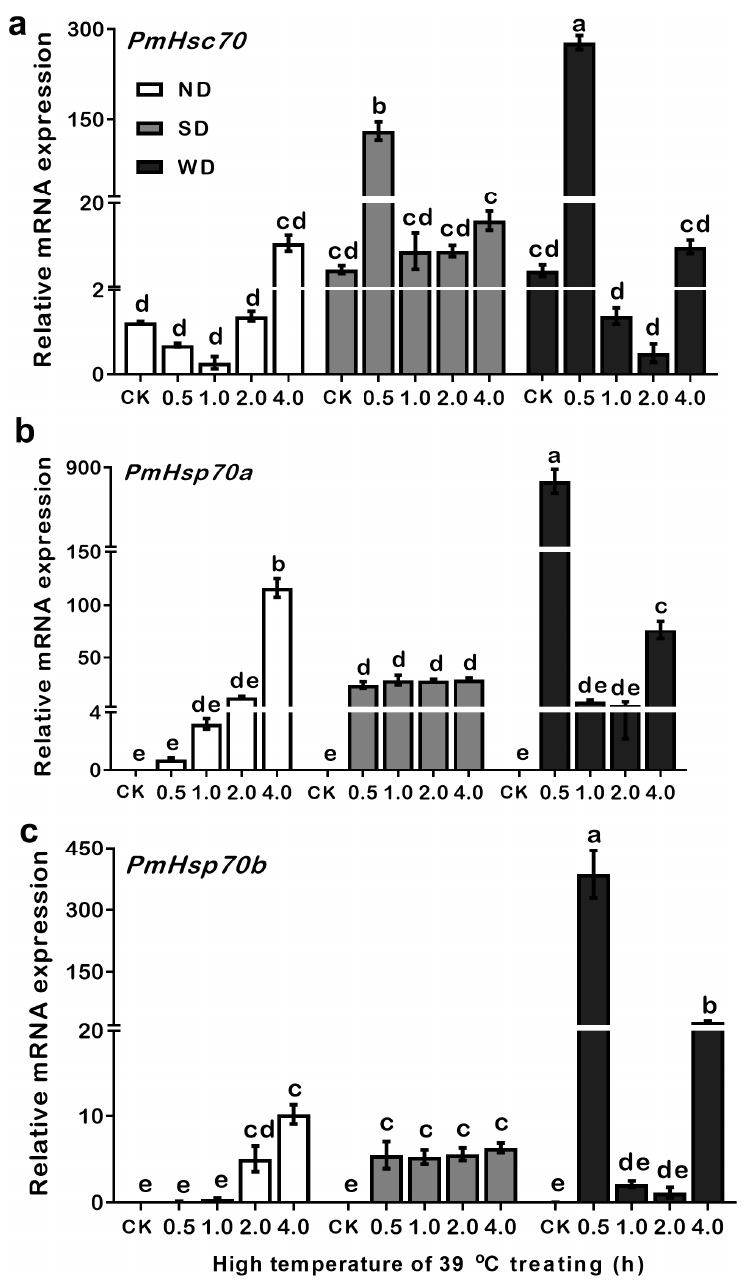
Figure 6. Relative mRNA expression levels of PmHsc70 ( a ), PmHsp70a ( b ), and PmHsp70b ( c ) in response to 39 ◦ C of heat stress in non-diapause (ND), summer diapause (SD), and winter diapause (WD) pupae of Pieris melete . The relative expression levels (Mean ± SE) are normalized to β -actin and 18S rRNA . Different letters above the bar indicate significantly differences by ANOVA and post hoc Bonferroni multiple-comparison ( p <